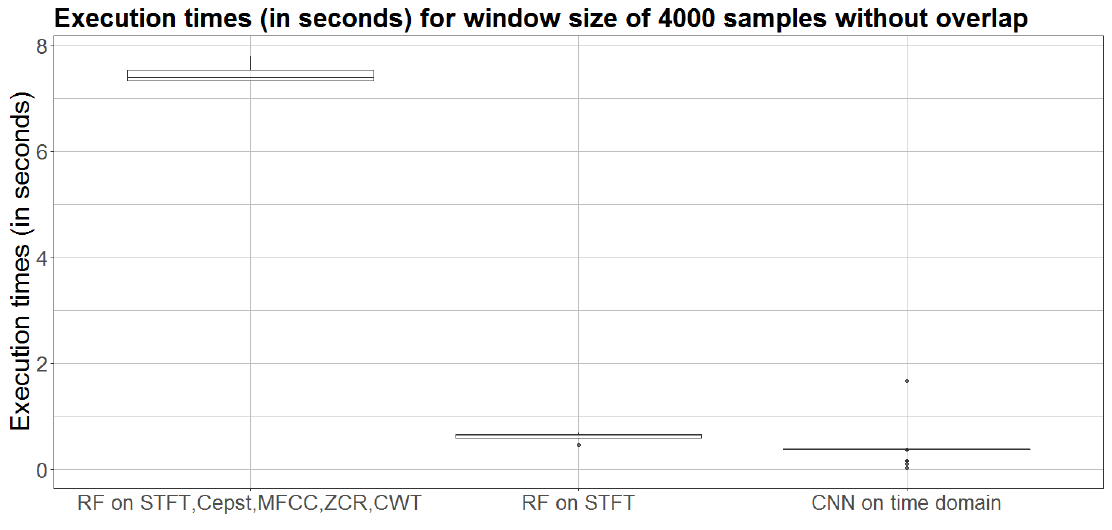
Figure 6. Comparison of the computational cost of our approach and other studies. Boxplots from left to right: RF with multiple features (mean time: 7.5 s), RF with only STFT (mean time: 0.6 s) and Model 5 of our CNN (mean time: 0.4